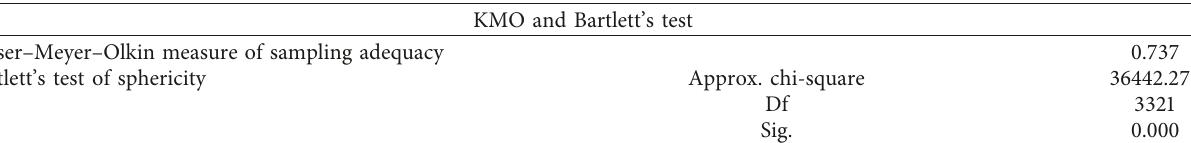
Table 2: KMO and Bartlett’s